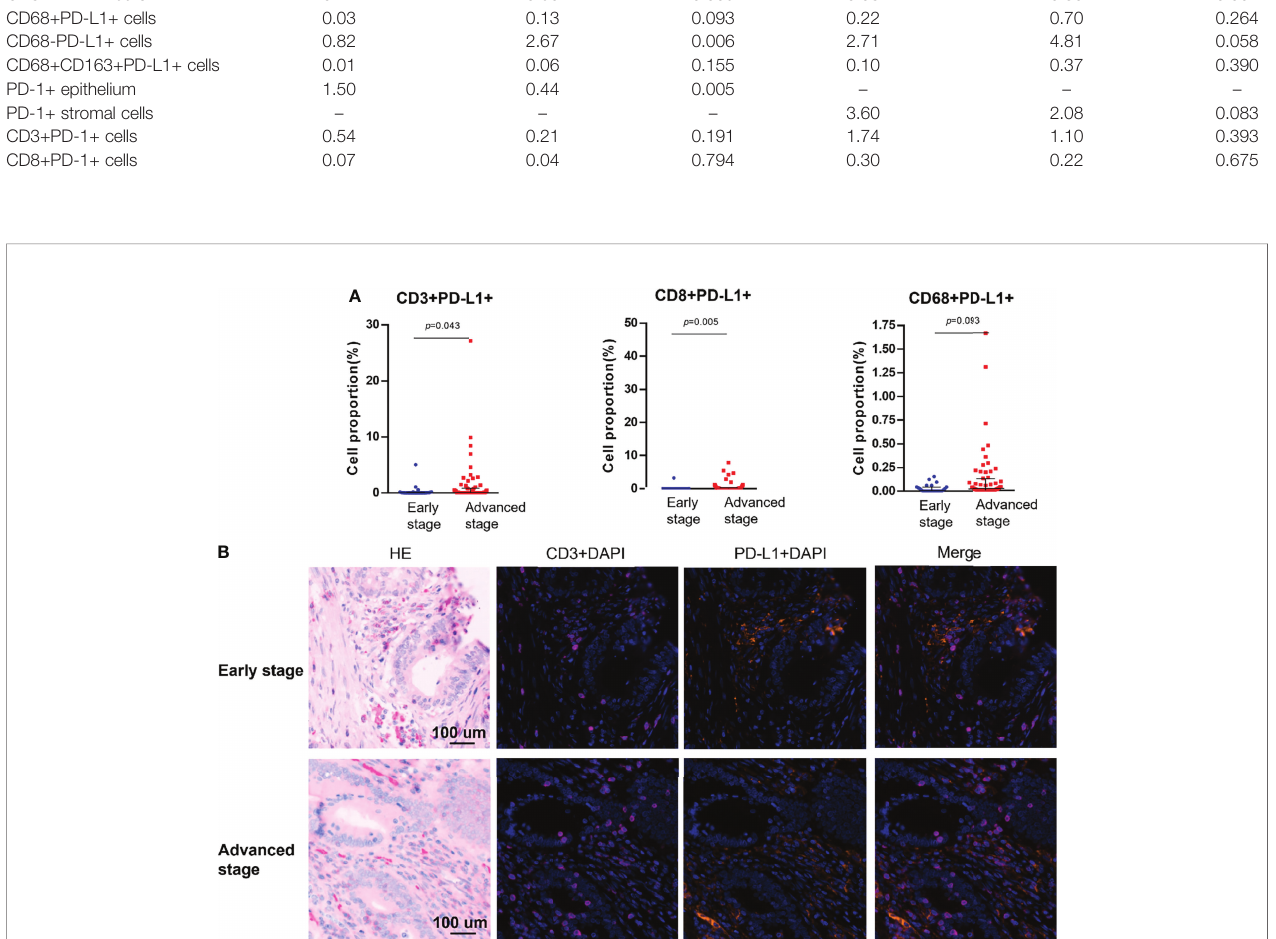
FIGURE 3 | Colocalization of PD-L1 with immune cells markers using multiplex immunohistochemistry. (A) Pairwise comparisons of PD-L1+ immune cells in the tumor epithelium in early-stage and advanced-stage tumors. (B) Representative images of PD-L1+CD3+ cells in dMMR CRCs by stage. Nuclei (DAPI, blue), CD3 (cytoplasm, Opal 650, purple), and PD-L1 (membrane, Opal 690,